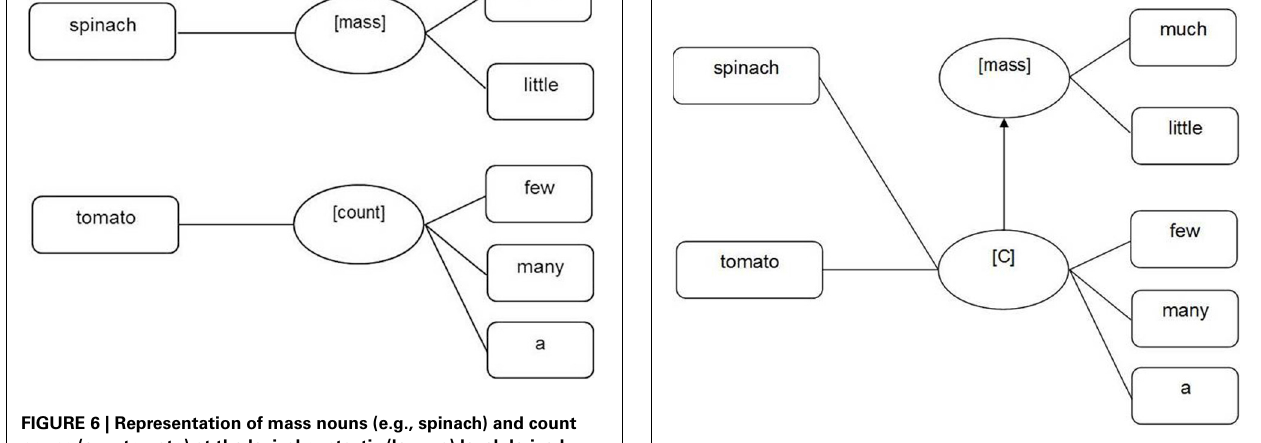
FIGURE 7 | Representation of mass nouns (e.g., spinach) and count nouns (e.g., tomato) at the lexical-syntactic (lemma) level derived from Taler and Jarema’s assumption